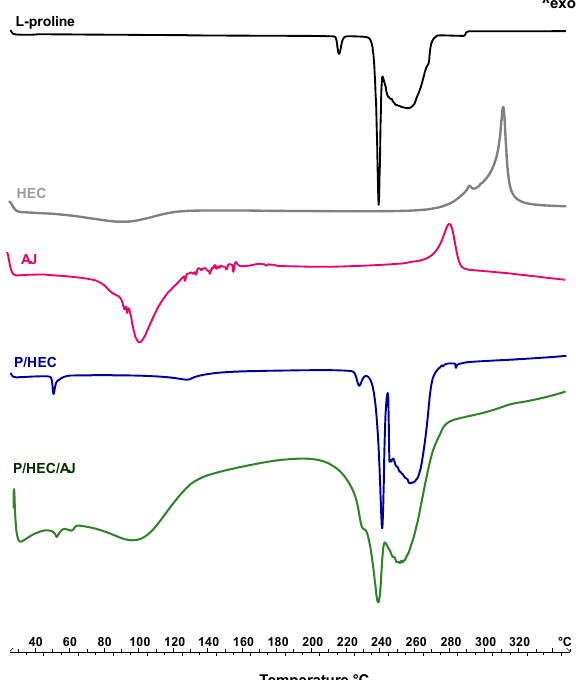
Figure 6. Differential scanning calorimetry (DSC) of raw materials (L-proline, black line, HEC, grey line, AJ, pink line), and physical mixture P/HEC (blue line) and P/HEC/AJ (green line).